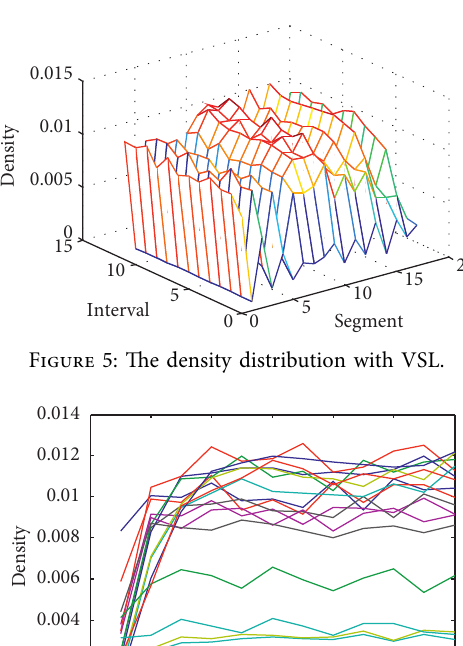
Figure 4: The density distribution without VSL.